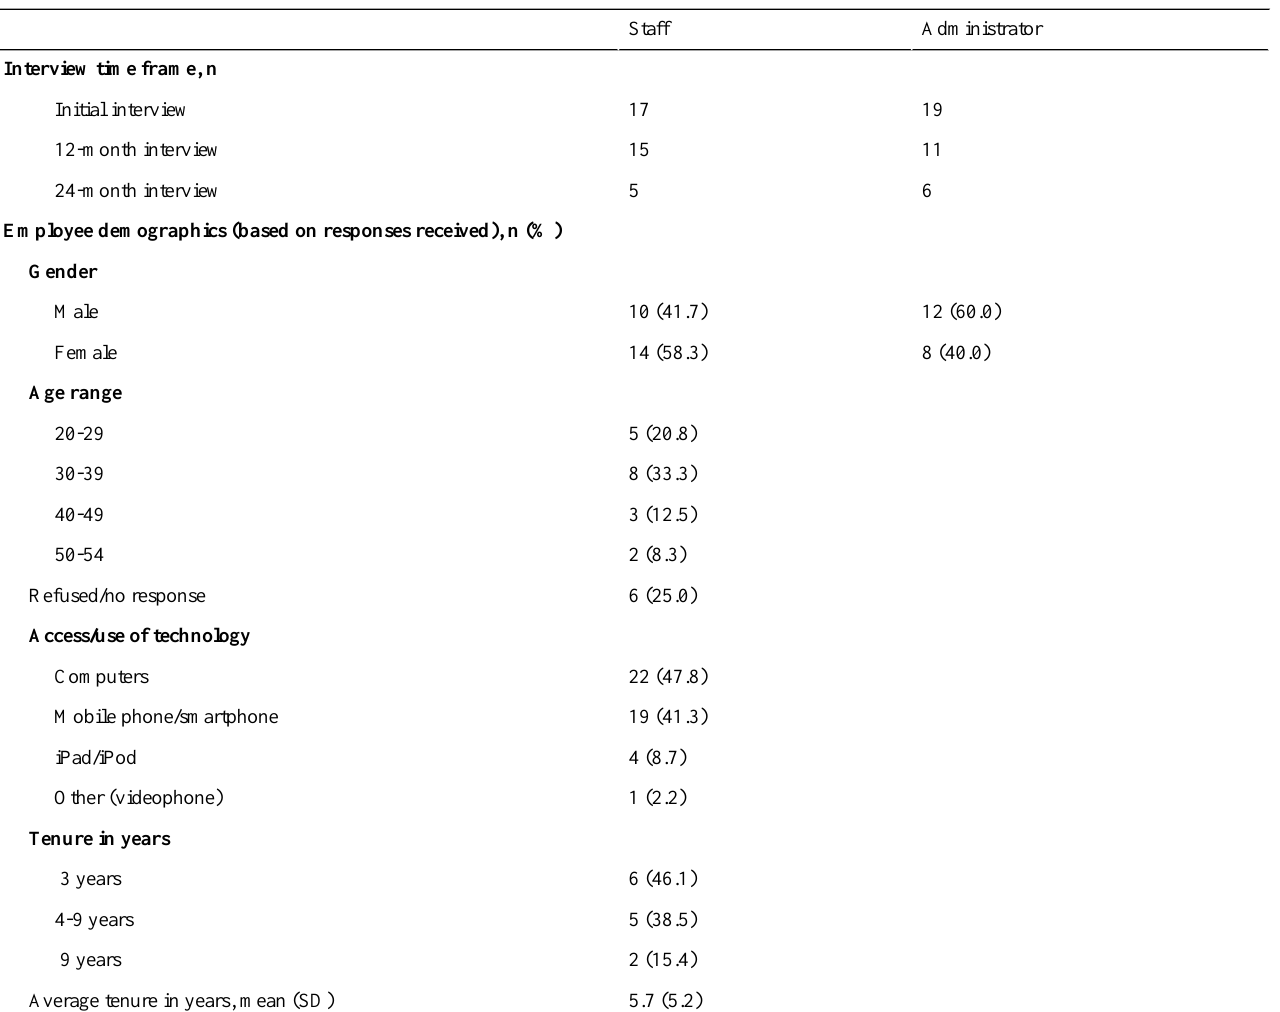
Table 3. Qualitative inquiry response rate and respondent